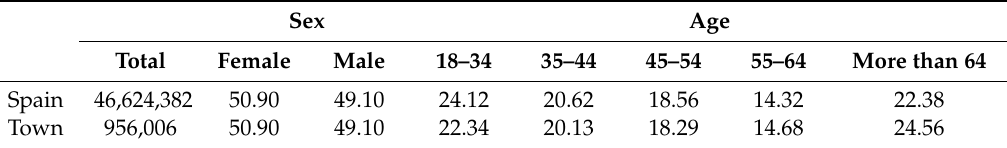
Figure A1. Smart Point of Sale for experimental settings. Table A1. Population by sex and age in Spain and in the town (%).